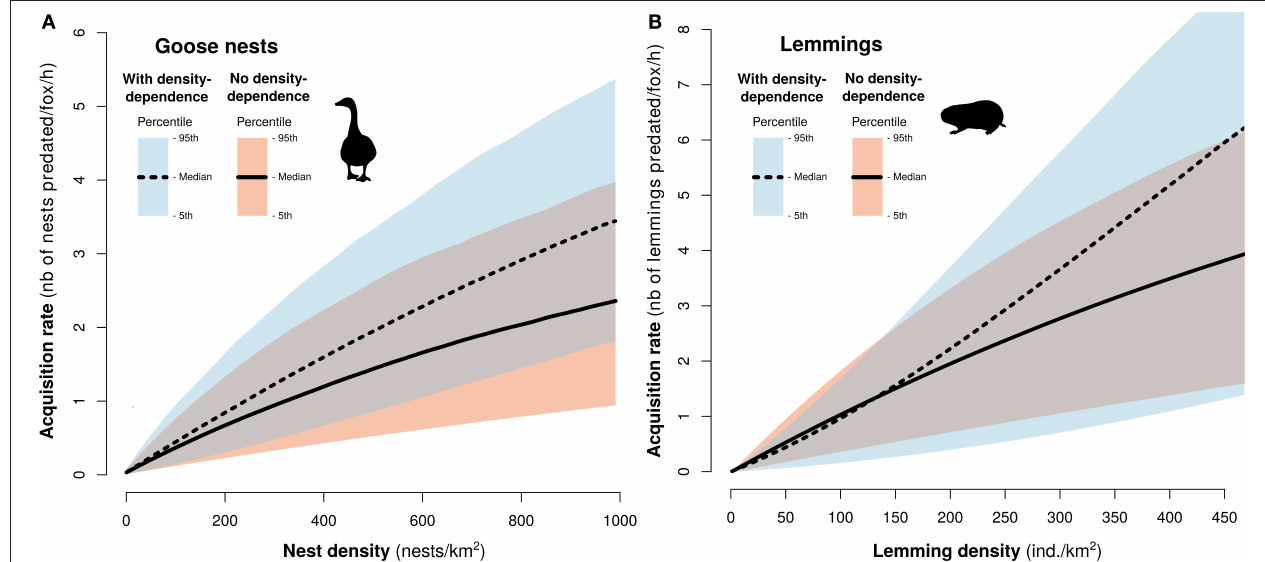
FIGURE 4 | Functional response models of arctic fox to goose nests (A) and lemmings (B) with and without density dependence on capture efficiency components, within the range of densities observed in the field. Black lines represent the median of the mechanistic model and the color bands represent the 95th percentiles based on 1,000